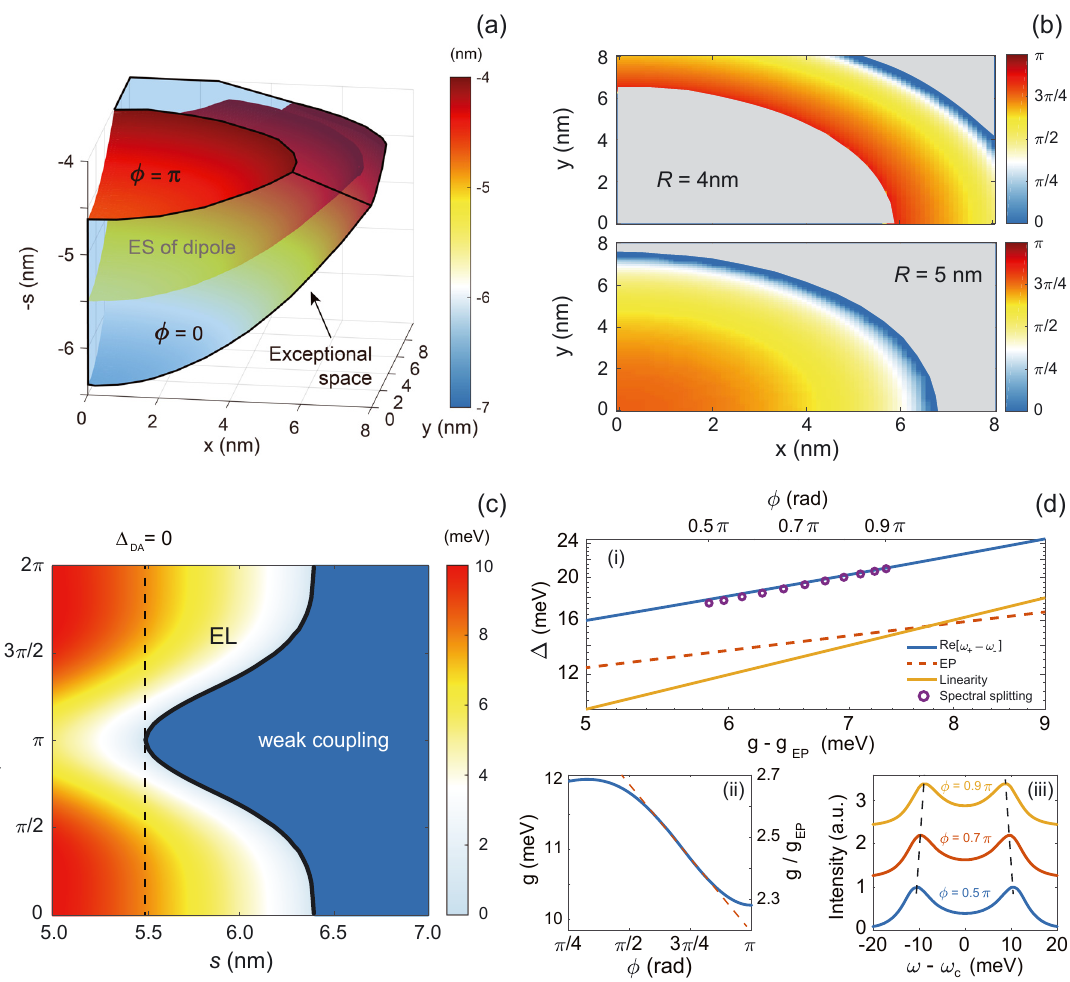
Figure 4: A high-dimensional quantum exceptional space. (a) Visualization of the exceptional space for QDs with the nondipole effect. The exceptional surface for a point dipole is also shown. (b) Exceptional surfaces for s = R = 4 nm (upper panel) and 5 nm (lower panel) in (a). No EP exists in the gray area. (c) Exceptional line as a function of s and 𝜙 for x = y = 0 nm and R = 5 nm. The gray dashed line labels the QD radius for eigenenergy splitting Δ = 0 in the DA. The blue area is the parameter region of weak coupling with the nondipole effect, while the black solid lines mark the EL between the strong and weak coupling. (d) Comparison of the eigenenergy splitting Δ (blue line) and the VRS (purple hollow circle) when varying g via rotating a 4 nm-radius QD from 𝜙 = 0 . 5 𝜋 to 0 . 9 𝜋 (i), where g and 𝜙 have a well linear relation (ii). The VRS is extracted from the SE spectra of QD (iii). The system configuration is the same as that in Figure 3(d). See the text for the expressions of ‘‘EP’’ and ‘‘Linearity’’ response in (i) of